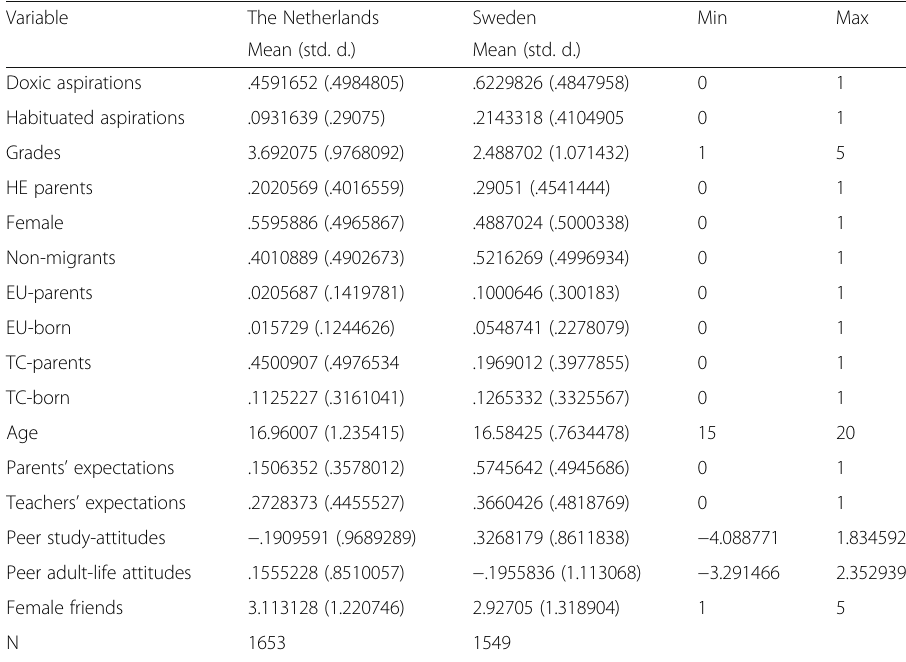
Table 1 Descriptive statistics, respondents from the Netherlands and Sweden Variable The